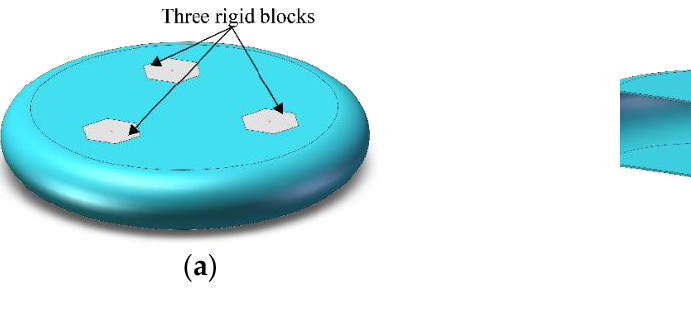
Figure 1. ( a ) The flexible asteroid landing lander; ( b ) the lander’s profile.